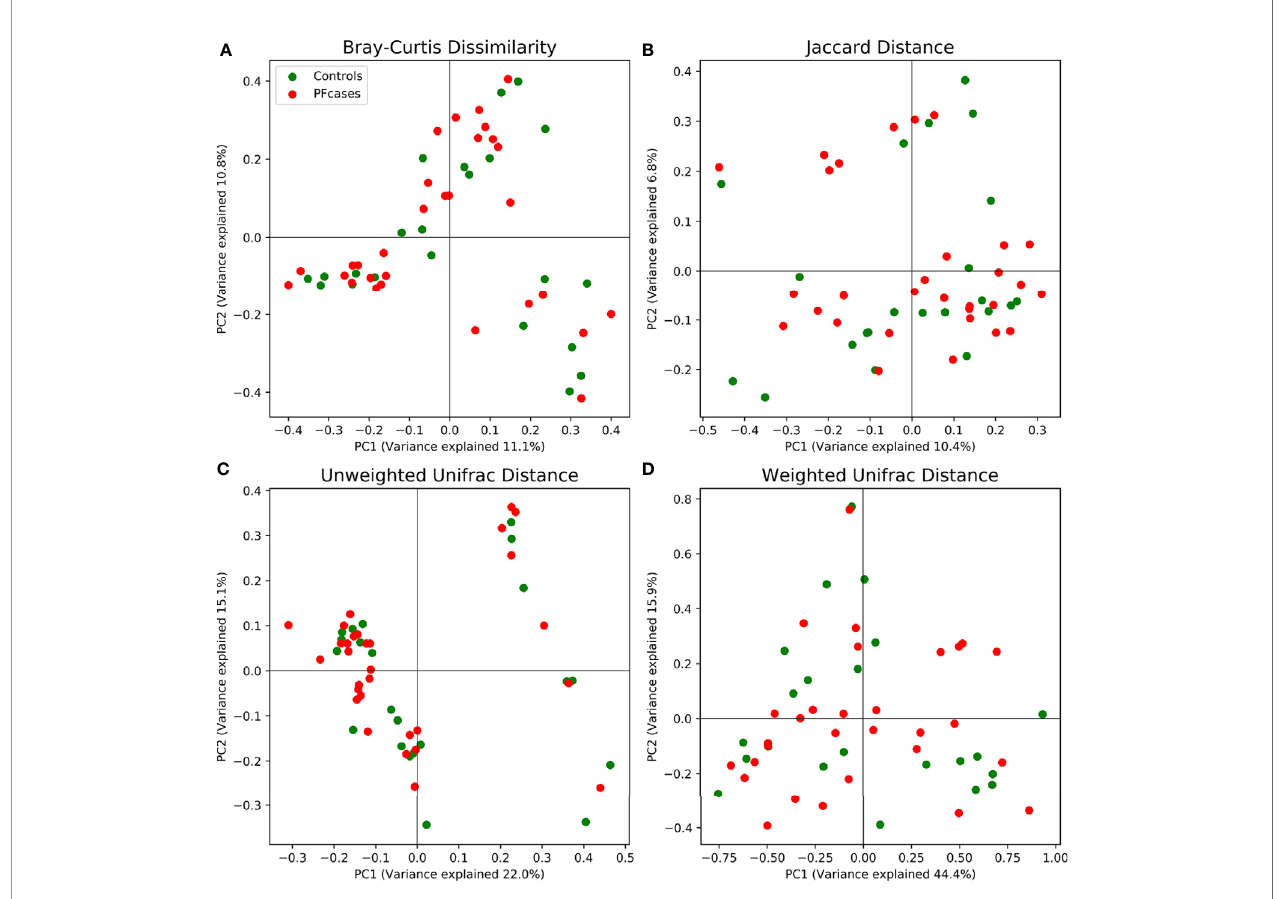
FIGURE 4 | Principal coordinate analysis results plotted for two of the most variance explaining components. Red and green dots represent PFcases and controls, respectively. In (A) Bray-Curtis dissimilarity, (B) Jaccard distance, (C) unweighted Unifrac distance and (D) weighted Unifrac distance are